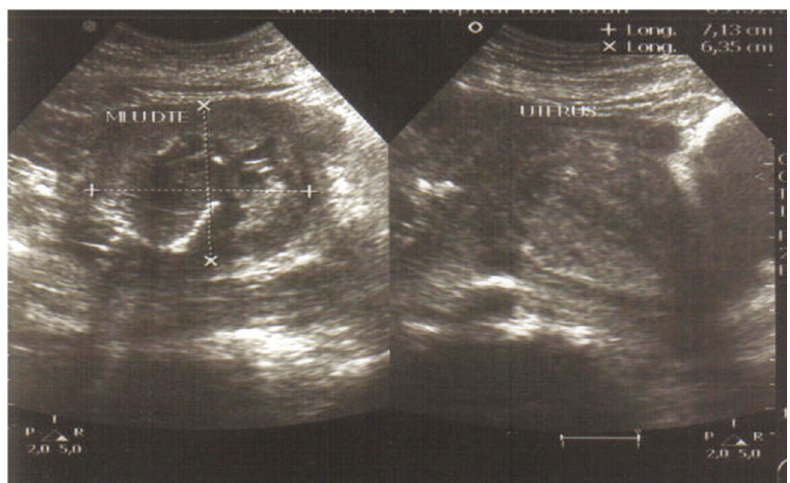
Figure 1: Empty uterus with right uterine lateral mass containing a fetus without cardiac activity.